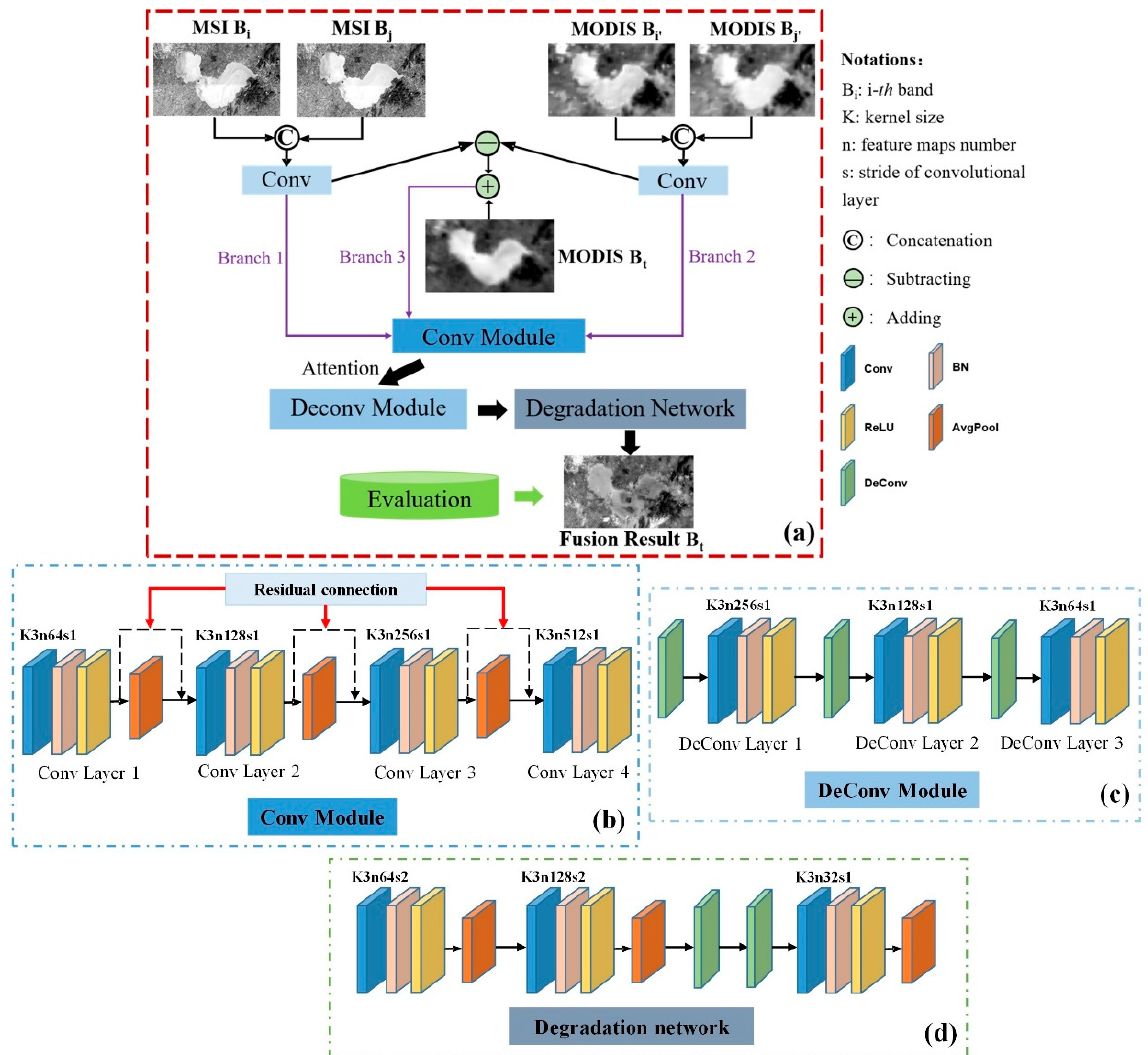
Figure 4. Structure and main components of the physical-based spatial-spectral deep fusion network (PSSDFN). ( a ) The entire PSSDFN flowchart. ( b – d ) The specific details regarding the Conv Module, DeConv Module, and Degradation Network, respectively.